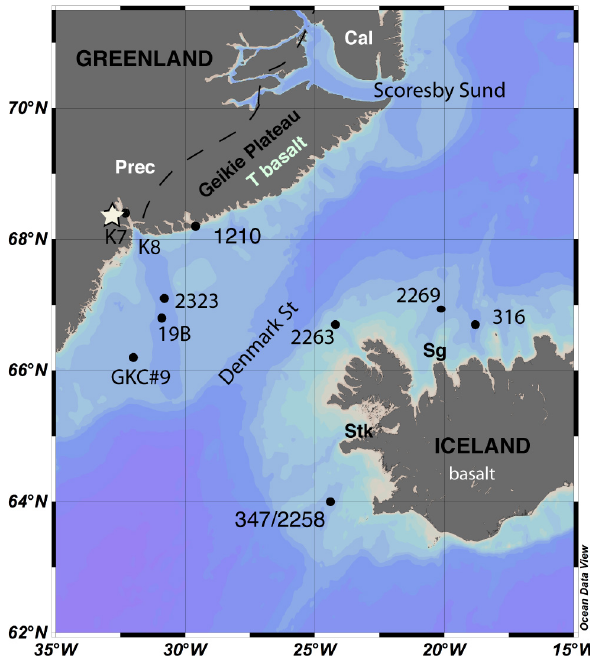
Fig. 1. Bathymetry and core locations – see Table 1 for details. The basalt outcrop of the Geikie Plateau is delimited by a dashed line. The letters Stk refer to the location of the Stykksholmur climate station (Fig. 3a) and Sg to the Siglunes transect (Fig. 3a). Core K14 (see text) is at the same location as core 1210. The large white star in Kangerlussuaq Fjord shows the location of the Tertiary felsic intru- sion. North of Scoresby Sund is an extensive outcrop of Caledonide (Cal) sediments and igneous rocks (Higgins et al., 2008). Elsewhere the bedrock is dominated by Precambrian (Prec)